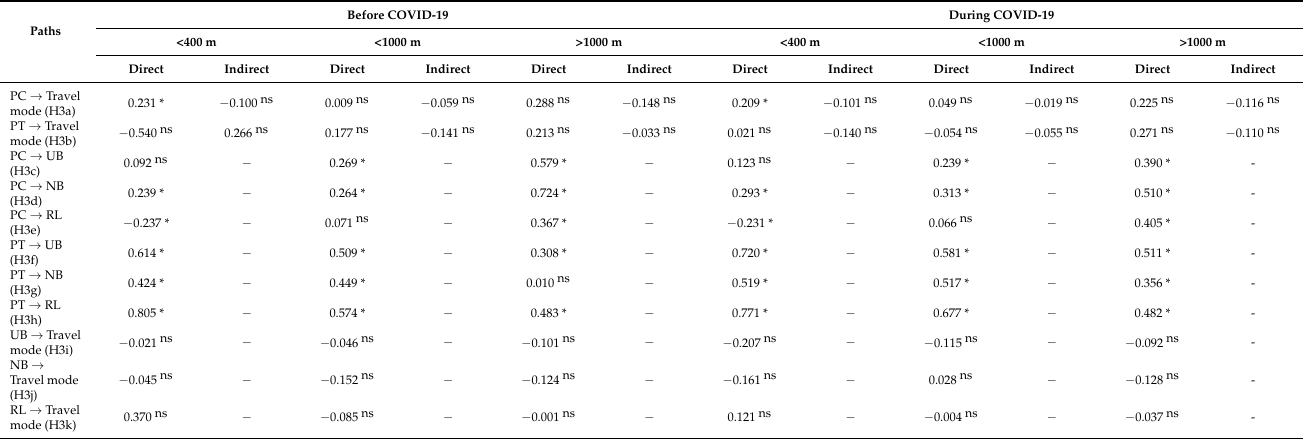
Table 7. Results of moderated mediation